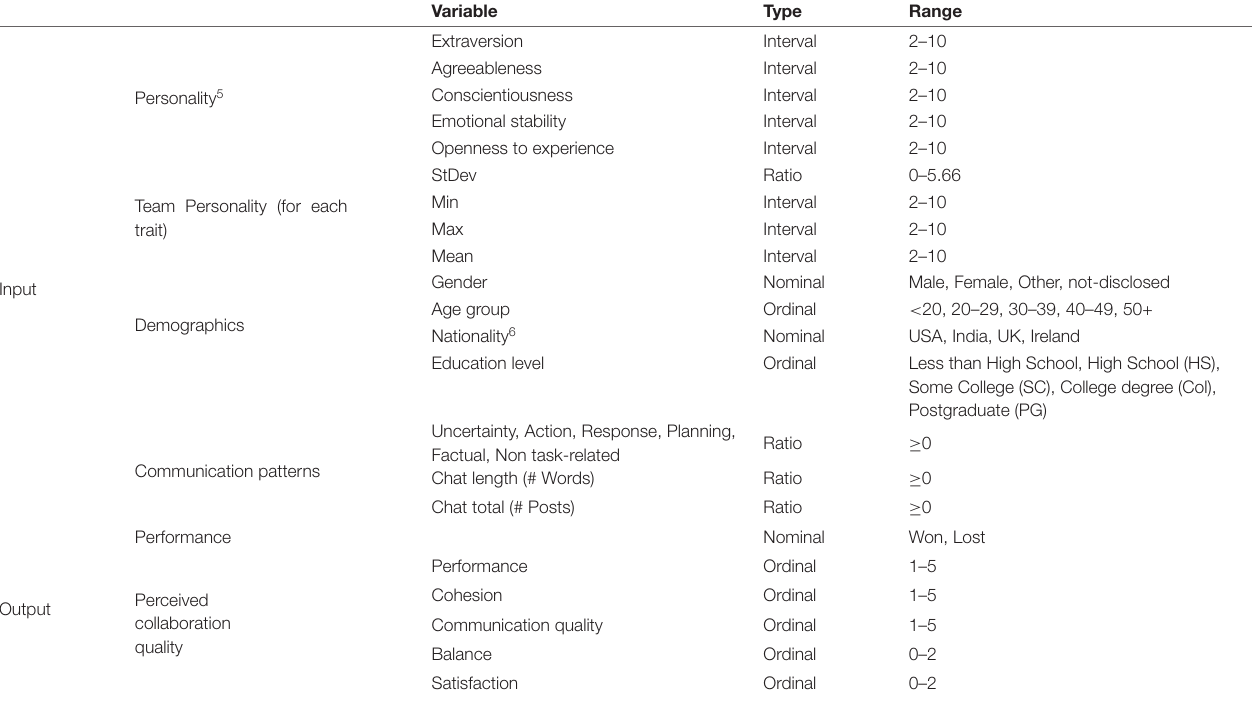
TABLE 2 | Summary of